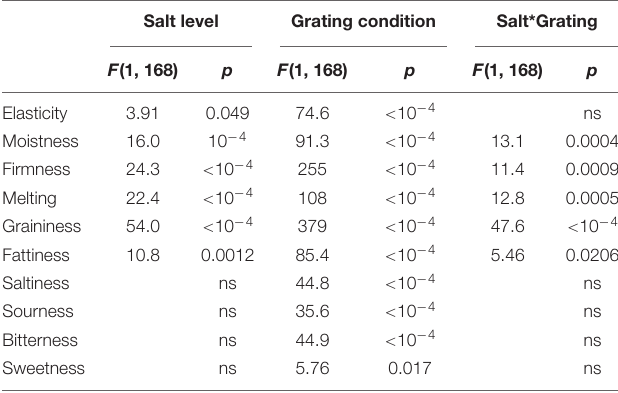
TABLE 1 | Sensory properties of regular and low salt semihard cheeses: Fisher statistics from ANOVA on the sensory attribute intensity (unflavored